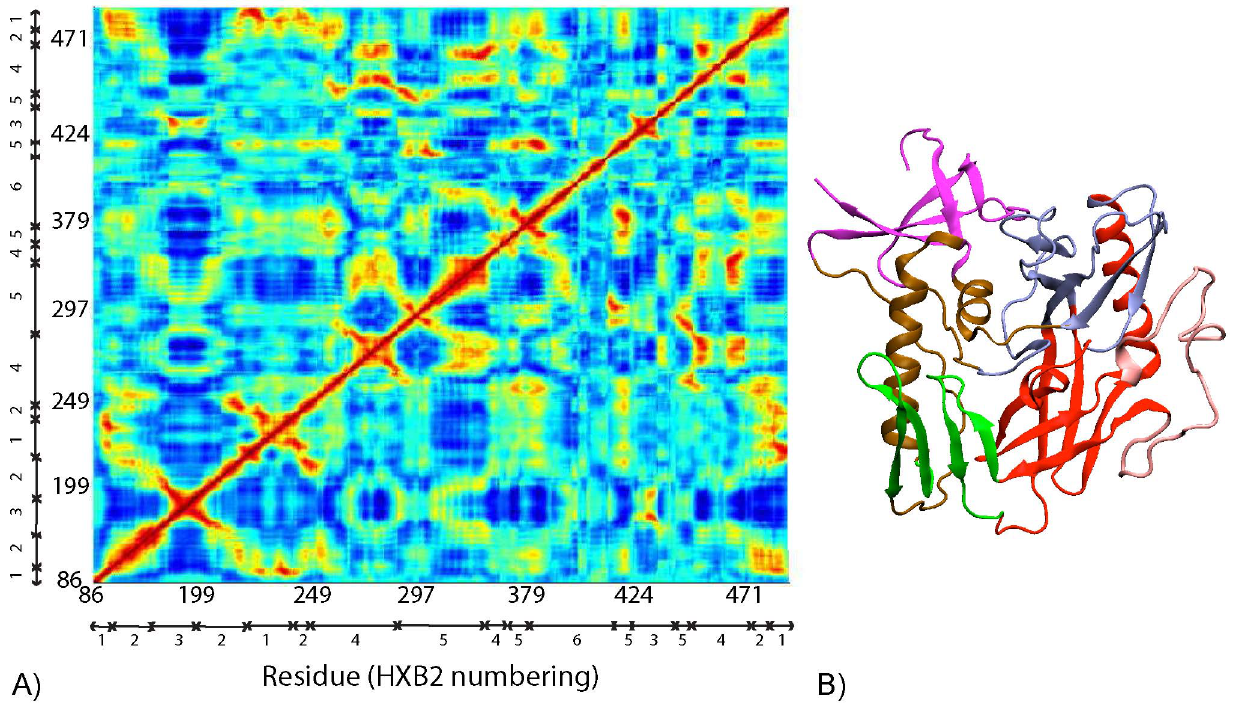
Figure 1. (A) The correlation of motion of each residue during the YU2 simulation. Blue represents anticorrelated motion, while red represents correlated motion. The residue numbering is HXB2. The subdomains are mapped in a gp120 core structure (B). Magenta represents the b - sandwich (region 1 in (A)), brown represents the ab -bundle (region 2), green represents the bridging sheet (region 3), ice blue represents the 7- stranded barrel (region 4), red represents the 6-stranded barrel and a 2 helix (region 5), and pink represents the V4 loop (region 6).